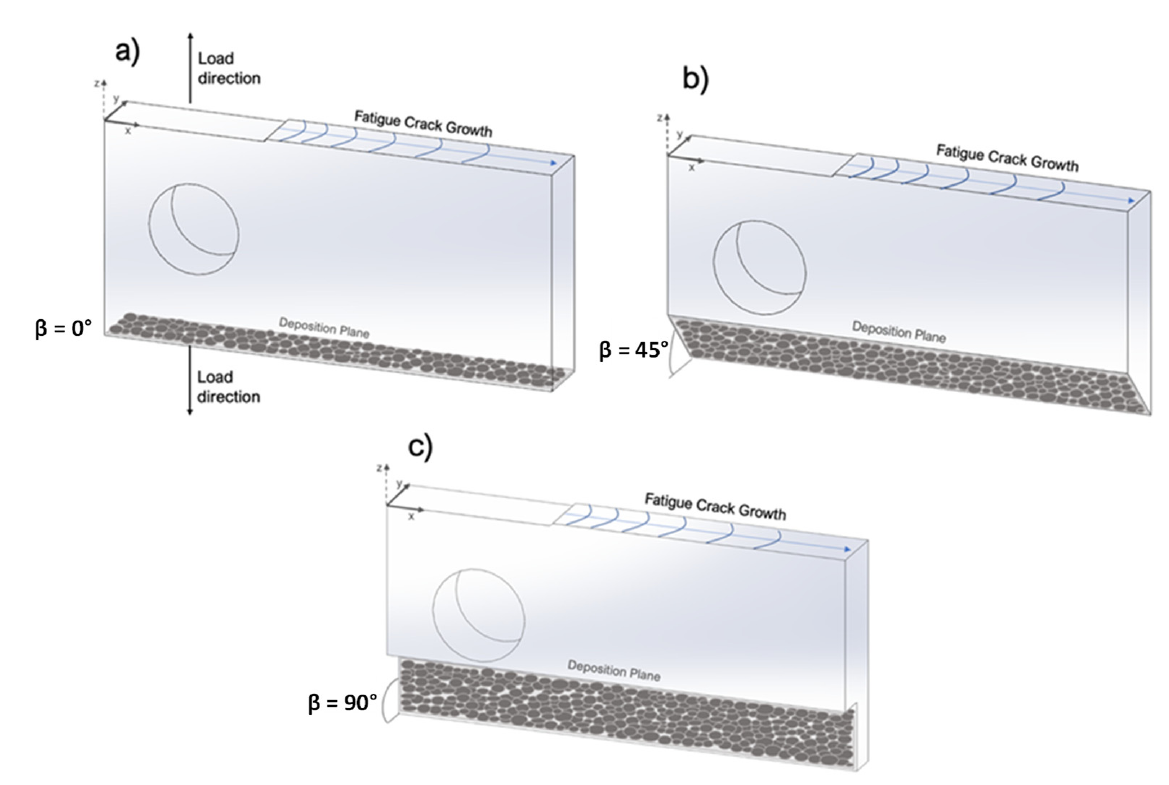
Figure 1. Disposition planes used in the LPBF process. ( a ) β = 0°, ( b ) β = 45° and ( c ) β = 90°.